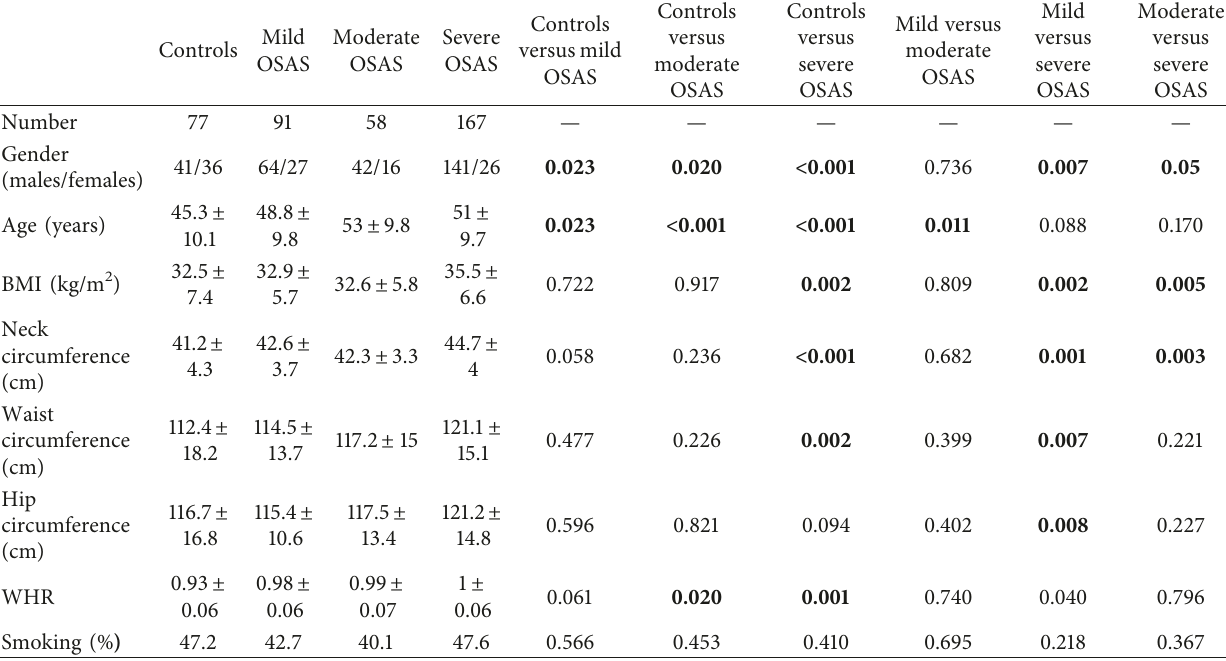
Controls versus